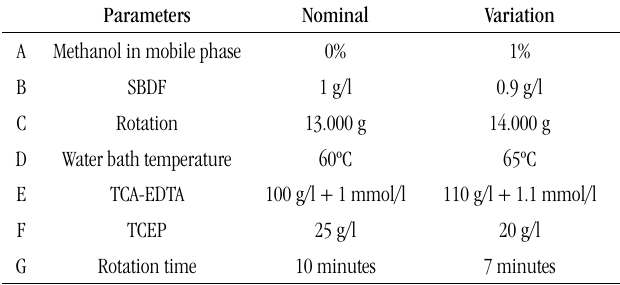
tABLE 1 – Analytical parameters in the nominal condition and in the variations proposed in the robustness